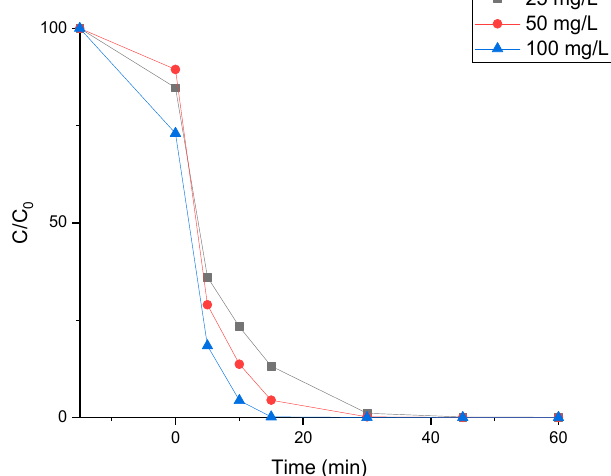
Figure 3. Degradation of SMX with TiO 2 P25, with loads of 25, 50, and 100 mg/L.